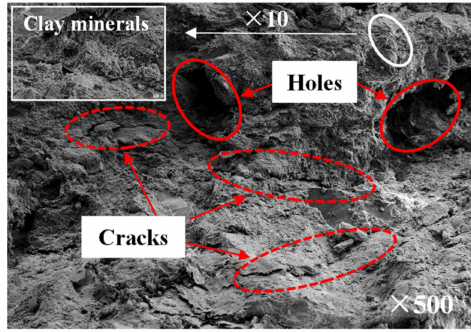
Figure 2. SEM image of a mudstone